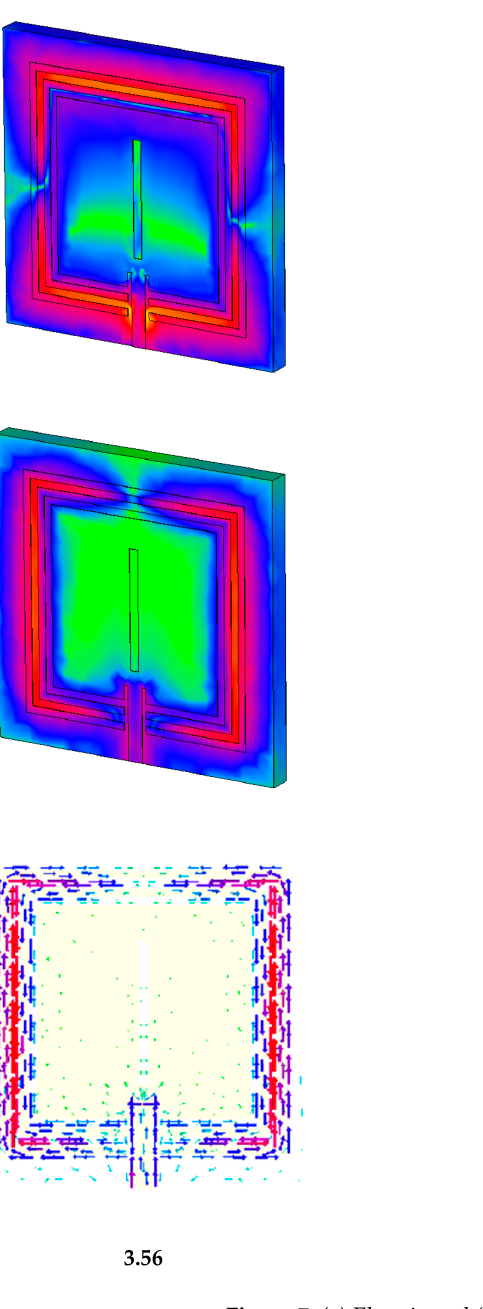
Figure 7. ( a ) Electric and ( b ) magnetic field, and ( c ) surface distribution at 3.56 and 4.14 GHz.